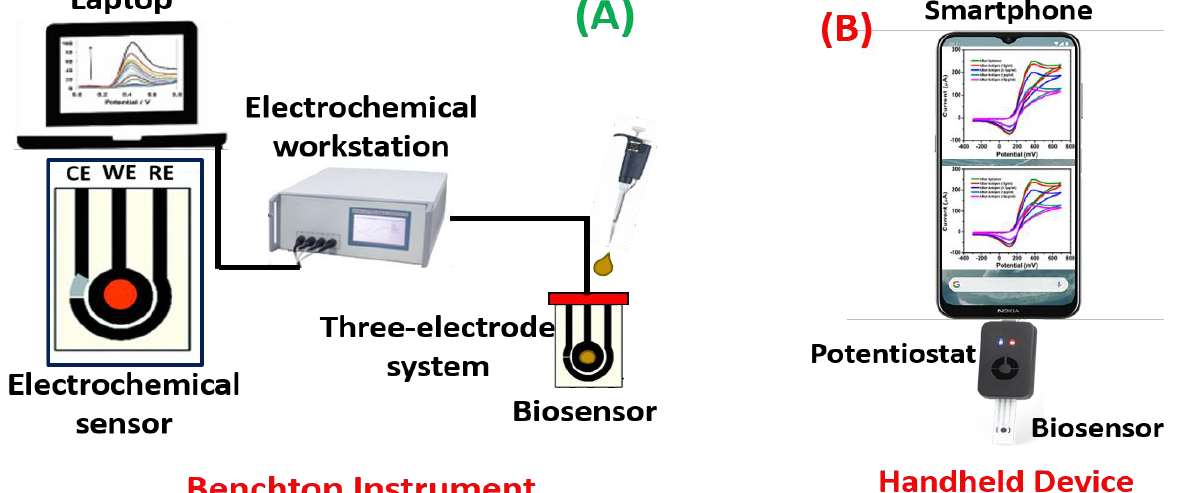
Figure 5. Schematic representation of electrochemical biosensors as ( A ) a benchtop instrument and ( B ) handheld device.